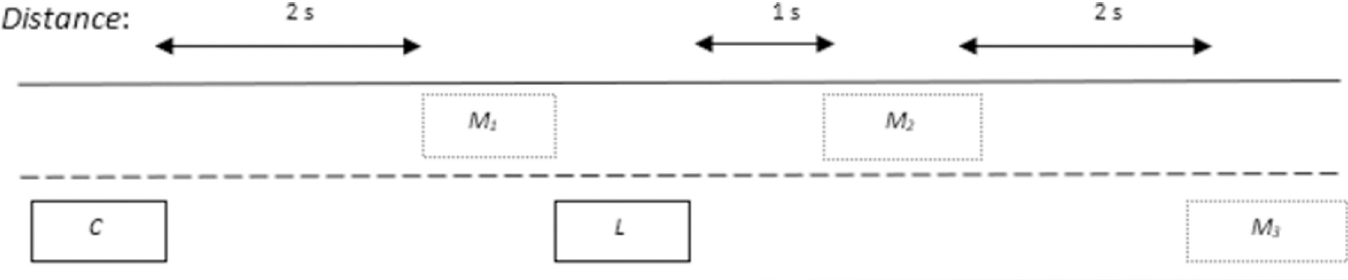
Fig 4. Position of marker targets for scenario 1.